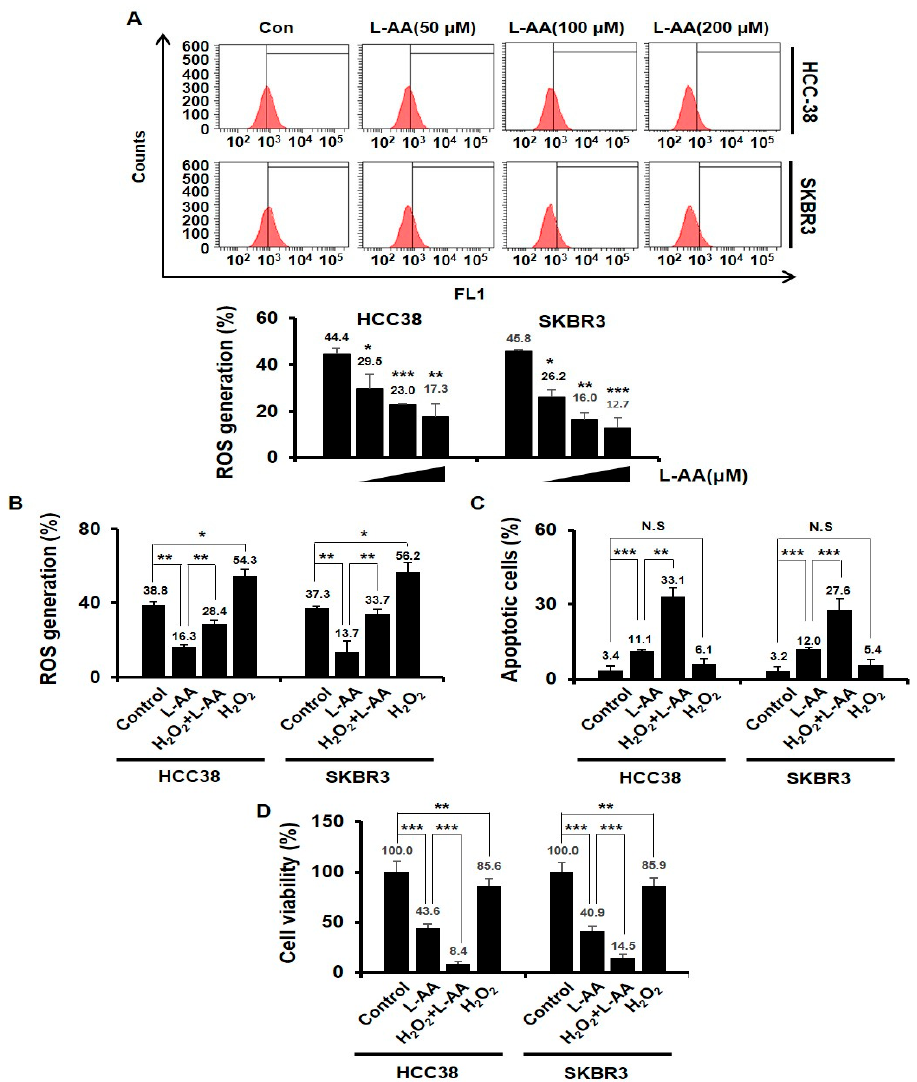
Figure 2. L-AA-induced apoptosis is not correlated to the intracellular reactive oxygen species (ROS) generation. ( A ) Breast cancer cells (HCC38 and SKBR3) were treated with various concentrations